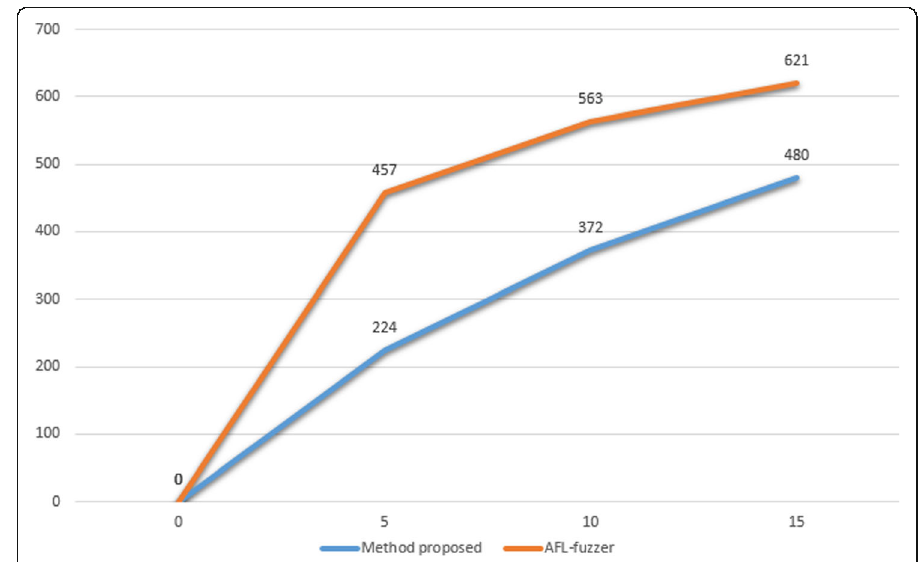
protocol realization. The paper first expounds the theory of dynamic taint analysis and then gives the definition of dynamic multi-modal sensor communication data required